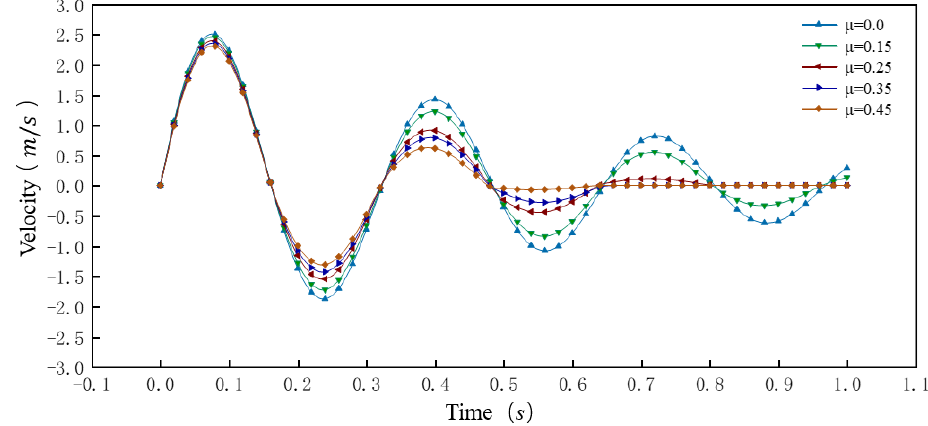
Figure 8. The sliding core velocity laws changes with friction coefficient.